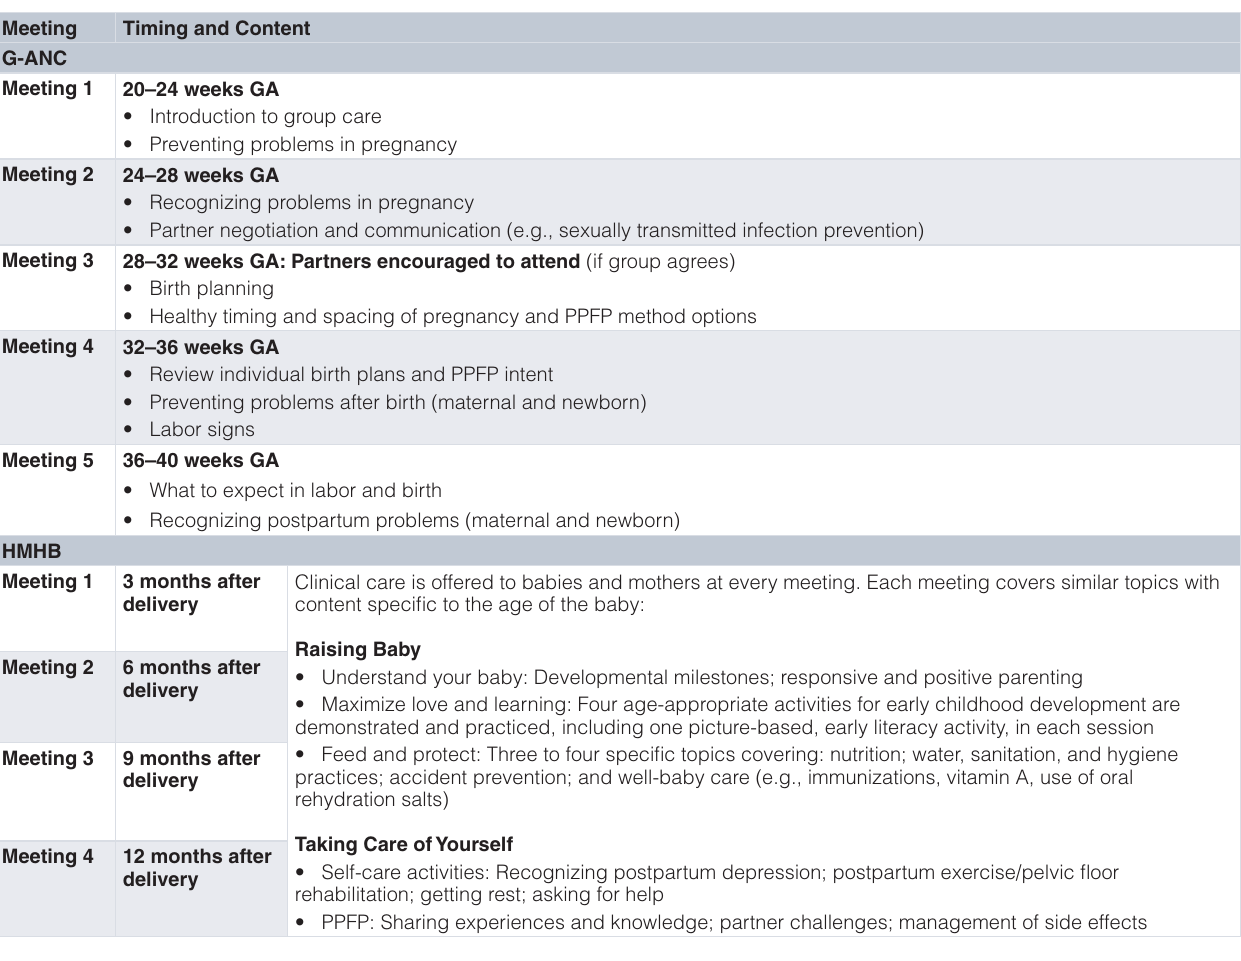
Table 4. G-ANC and HMHB meeting content. Summary of activities and content covered during each group meeting before and after delivery.